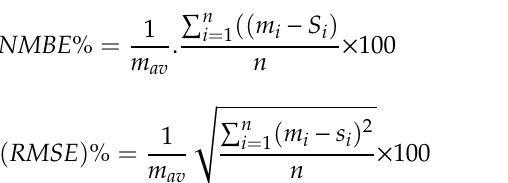
Figure 1. Framework of model validation (based on Hwa Cho and Sook Kim evaluation and American Society of Heating, Refrigerating and Air-Conditioning Engineers (ASHRAE) 14–2002 whole building calibrated approach).